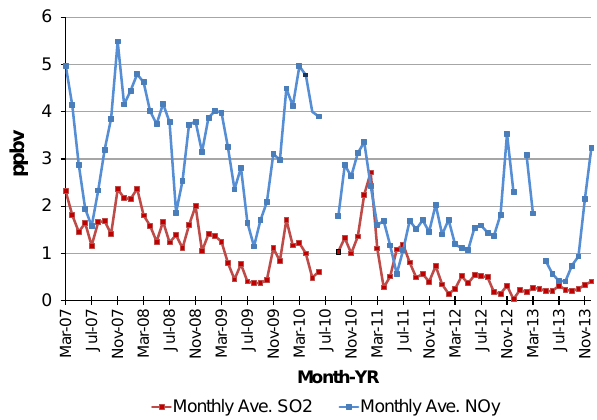
Figure 5. Average monthly SO 2 and NO y concentrations at Look Rock,